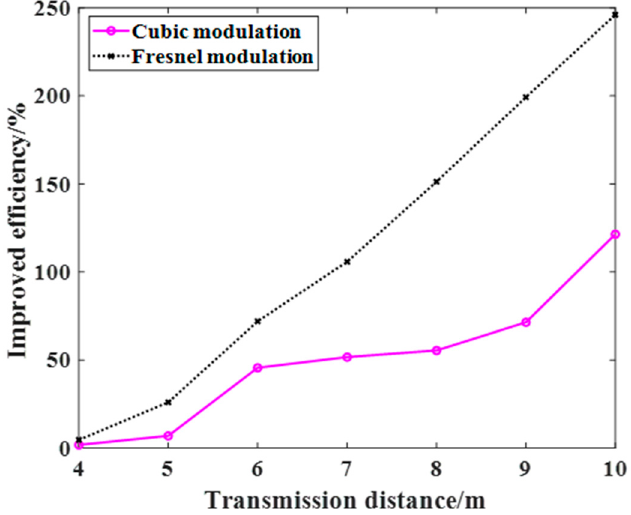
Figure 8. The efficiency of power improvement.